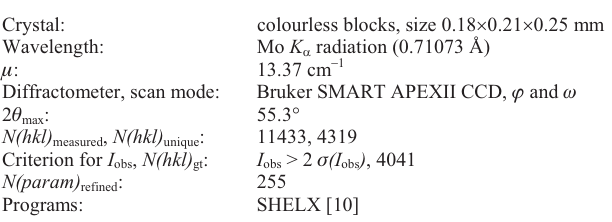
Table 1. Data collection and